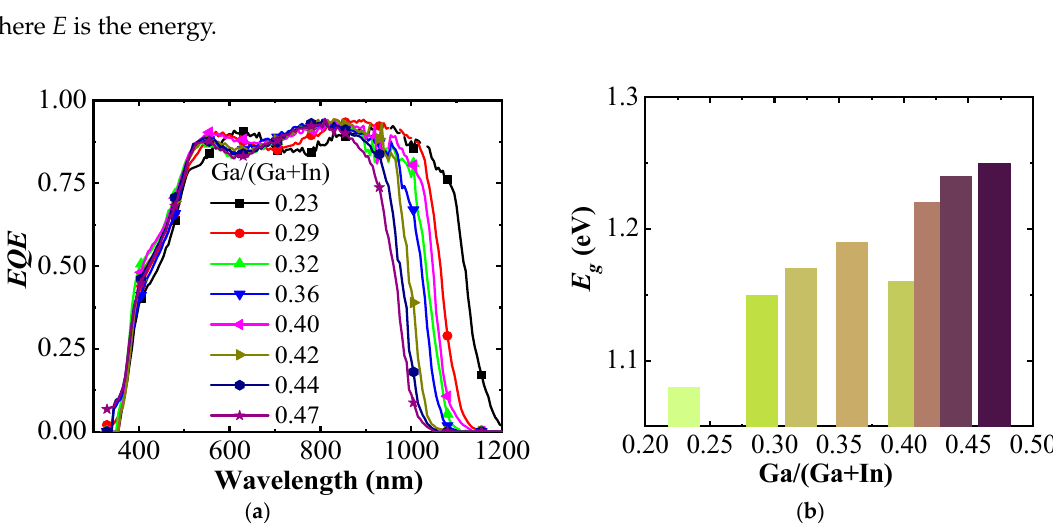
Figure 4. ( a ) External quantum efficiency (EQE) for the (A)CIGS with different Ga/(Ga + In) ratios, ( b ) E g versus Ga/(Ga + In).